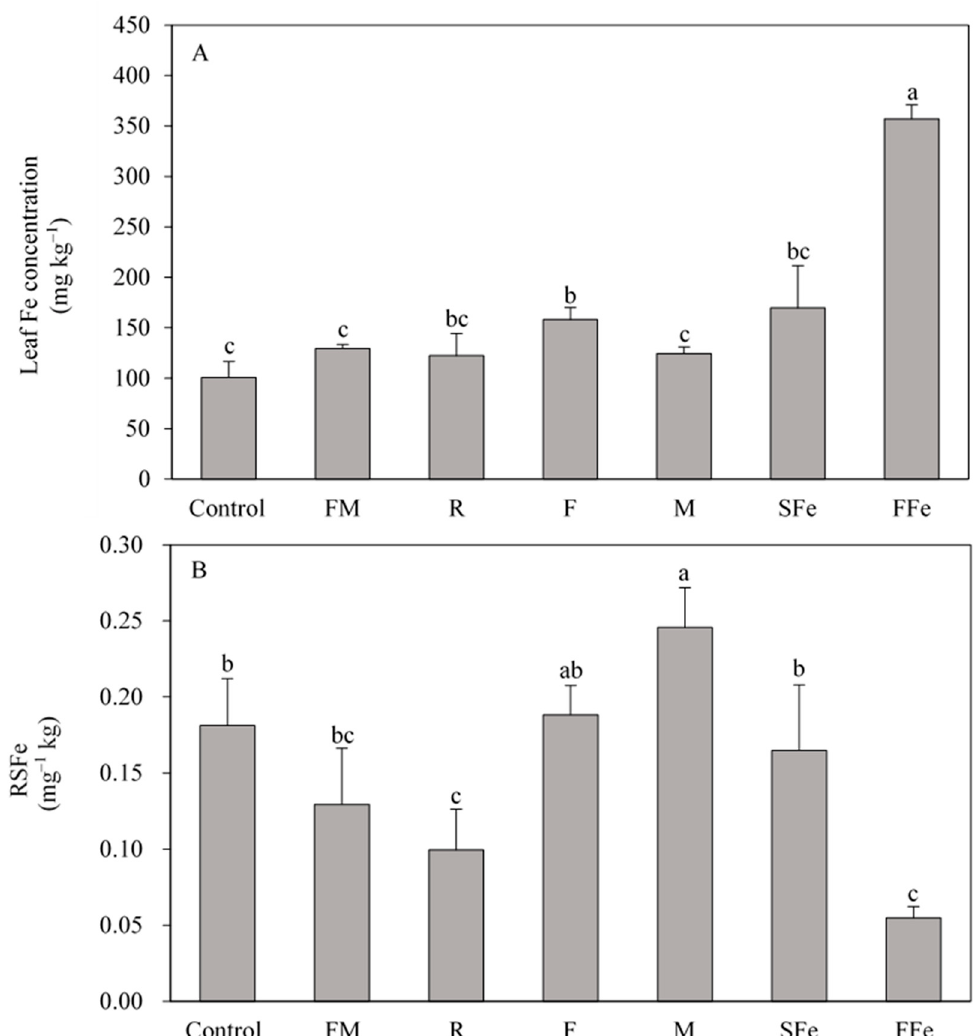
Figure 6. Leaf Fe concentration ( A ) and RSFe ( B ) of HG-QA grown in different practices. RSFe: the ratio of SPAD to the leaf Fe concentration. HG-QA: “Huangguan” pear grafted onto quince A. Control: ridging with landscape fabric mulching and without other treatments; FM: flattening with landscape fabric mulching, R: ridging without landscape fabric mulching; F: flattening without landscape fabric mulching; M: Manure application; SFe: Fe application in soil; FFe: Foliar Fe application. The different letters mean statistical differences between treatments, p < 0.05 (Benjamini–Hochberg